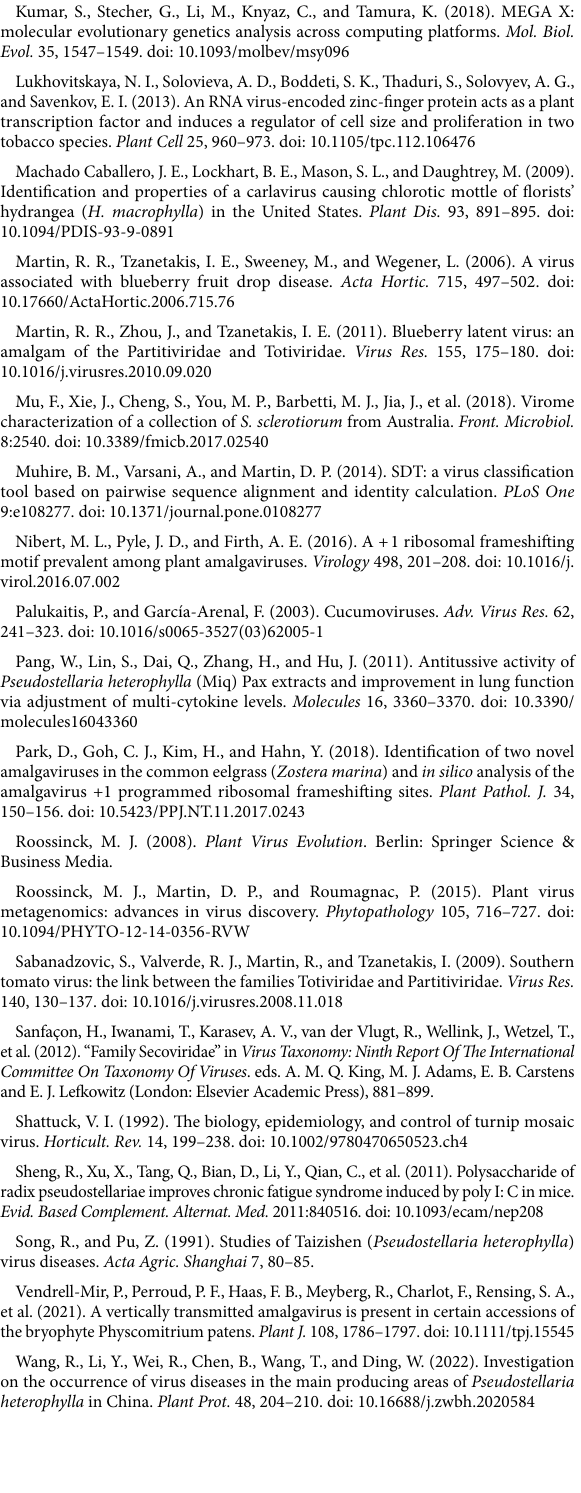
SUPPLEMENTARY TABLE S8 Pairwise amino acid identities of the CP of PhCV1, PhCV2, PhCV3, Ph- JVC, Ph-StCV1, and the 15 most similar